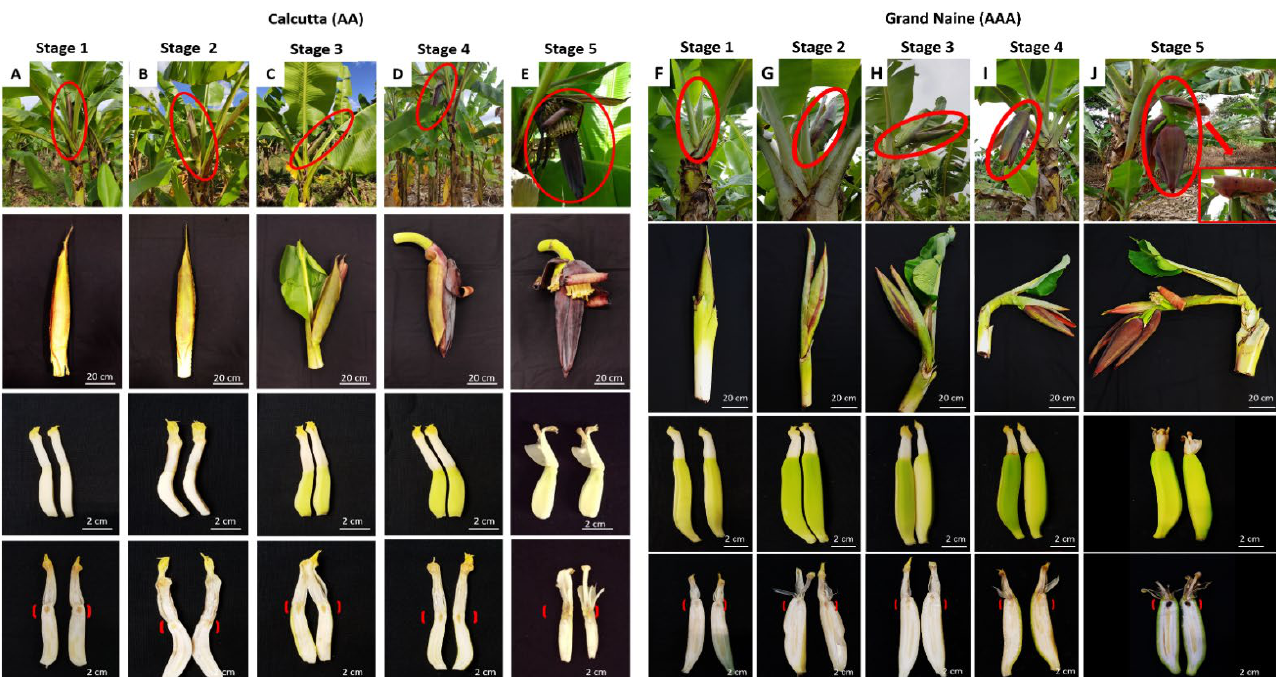
Figure 5. Proposed developmental stages of pistillate (female) flowers of the diploid Calcutta 4 and Grand Naine cultivars: ( A , F ) partial emission of the inflorescence from the pseudostem—vertical position (inflorescence base not visible); ( B , G ) total emission of the inflorescence from the pseudostem—vertical position (visible base of the inflorescence); ( C , H ) total emission of the inflorescence—horizontal position to the ground; ( D , I ) inflorescence in pendulous position to the pseudostem with closed flowers (pre-anthesis); ( E , J ) inflorescence in pendulous position to the pseudostem with open flowers (anthesis). [ ], Distal region of the ovary (septal nectary).